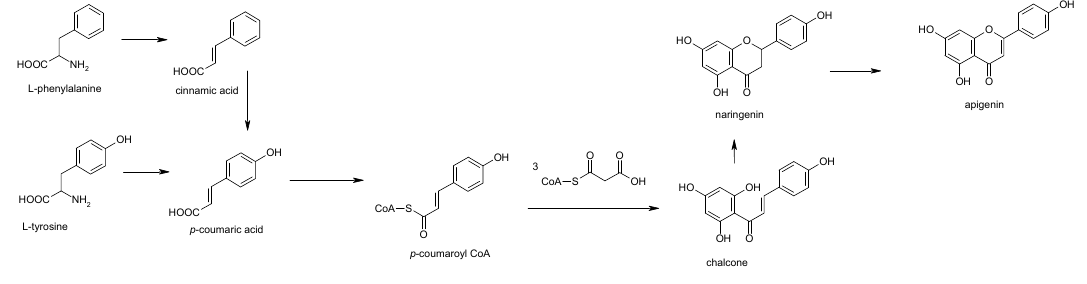
Figure 3. Biogenetic pathway of apigenin biosynthesis.